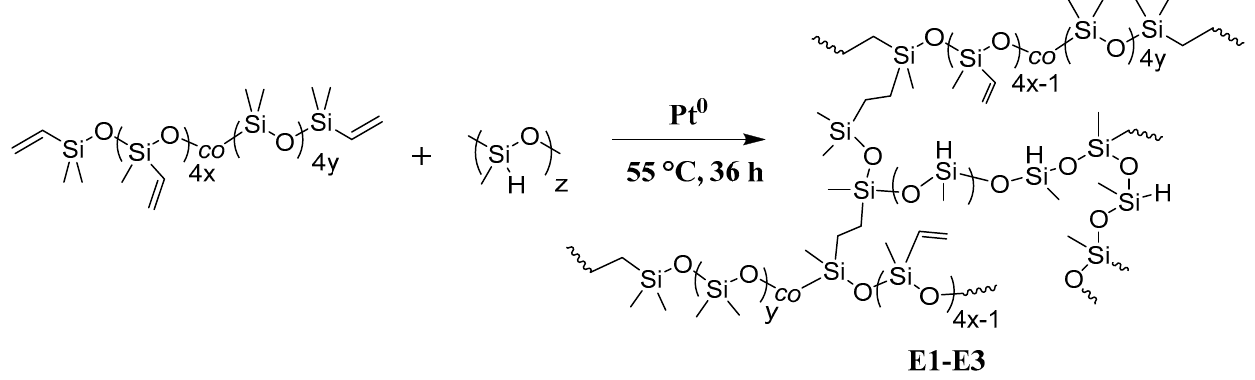
Scheme 2. Cross-linking of PH x by hydrosilication catalyzed by Pt 0